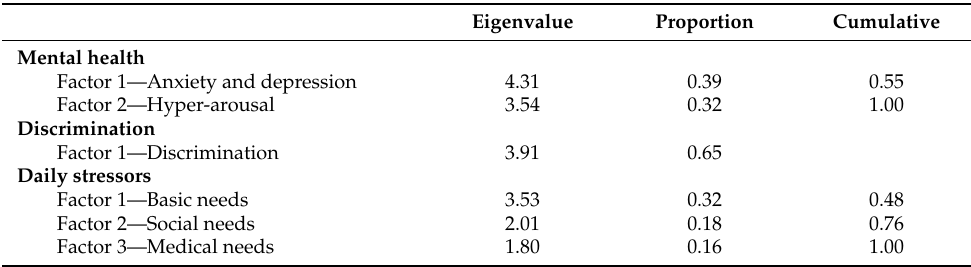
Table 4. Exploratory factor analysis.